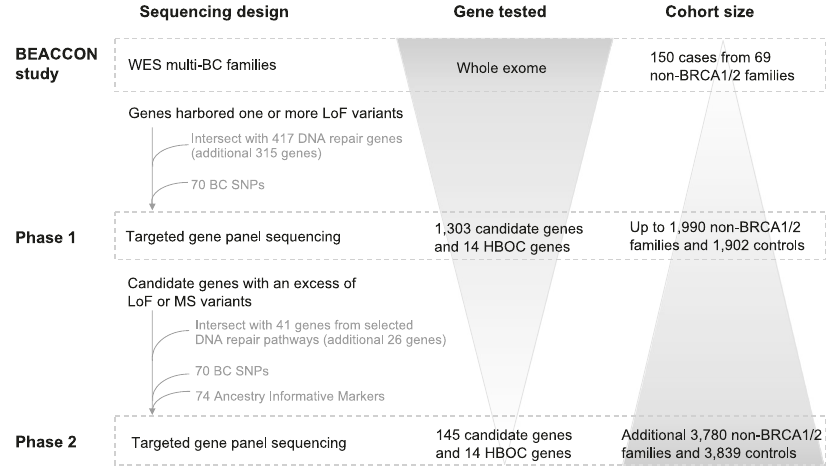
Fig. 1 Breast cancer predisposition gene discovery and validation strategy in the BEACCON study. Whole-exome sequencing (WES) was carried out on 150 BC affected cases from 69 high-risk BC families. Based on the data from the WES and DNA repair genes identi fi ed through literature review, 1303 candidate genes and 14 previously reported HBOC genes were screened in up to 1990 index non-BRCA1/2 familial BC cases and 1902 controls. One hundred forty- fi ve genes selected from phase 1 and the same 14 HBOC genes are screened in an independent cohort of 3780 index non-BRCA1/2 BC cases and 3839